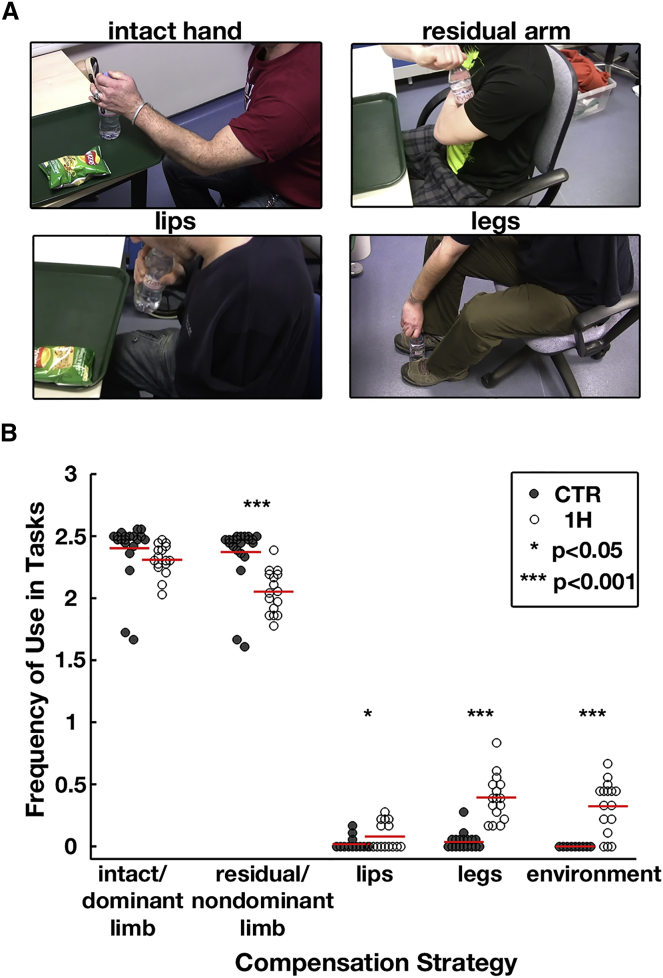
Compensatory Behavior in One-Handers Involves Multiple Body Parts(A) Examples of one-handers opening a bottle during the ecological task.(B) Group comparison of behavioral scores for each body part across tasks. A greater proportion of one-handers (white dots) used their lips, legs, and environment to execute the tasks compared to controls (gray dots). Dots represent individual participants; red lines represent group means. CTR, control participants; 1H, one-handers.